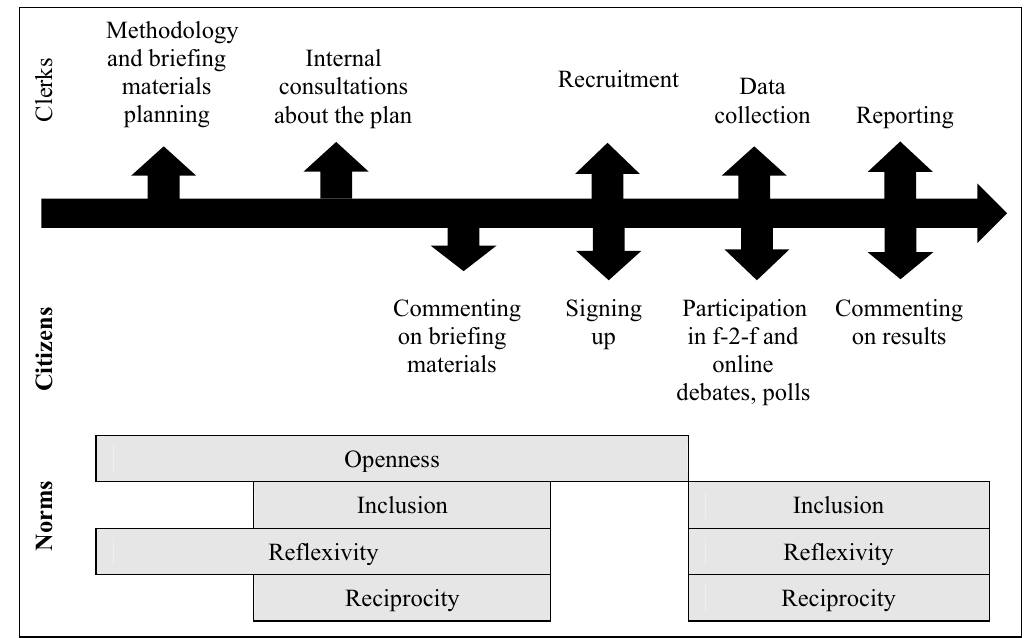
Figure 1: The actions of clerks and citizens with inDialogue, in reference to the norms of deliberation.